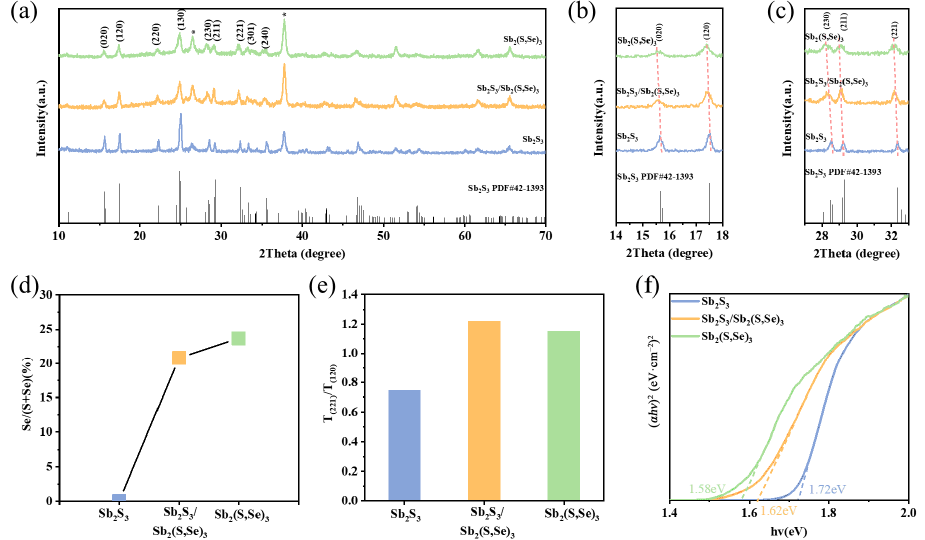
Figure 3. ( a ) XRD patterns of Sb 2 S 3 , Sb 2 (S, Se) 3 , and Sb 2 S 3 /Sb 2 (S, Se) 3 films deposited on FTO/SnO 2 /CdS substrates. Asterisks (*) index the peaks of FTO. Corresponding XRD patterns in the 2 θ range of ( b ) 14 ◦ ~18 ◦ and ( c ) 27 ◦ ~33 ◦ . ( d ) Se/(S + Se) ratios of different films, which were derived from EDS data. ( e ) TC (221) /TC (120) ratios of different films. ( f ) Tauc plots calculated from UV-vis absorption spectra for different films.